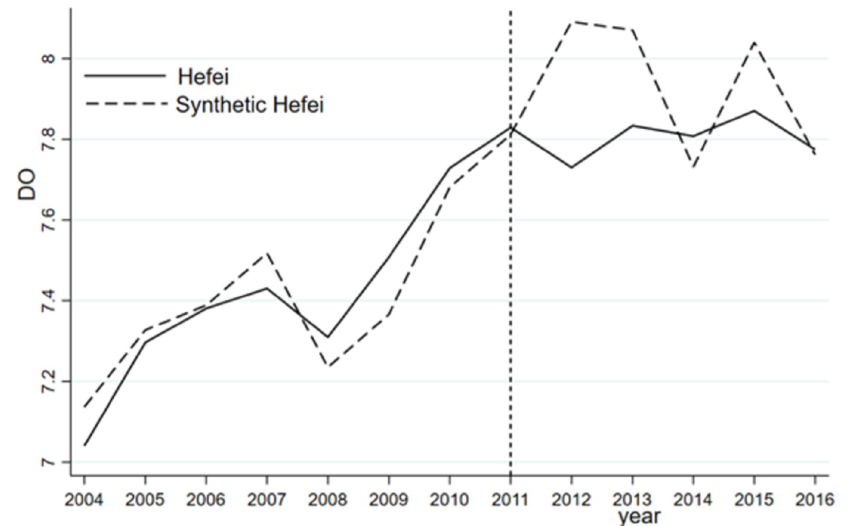
Fig 6. DO of Hefei and synthetic Hefei (excluding Beijing, Shanghai, and Tianjin).